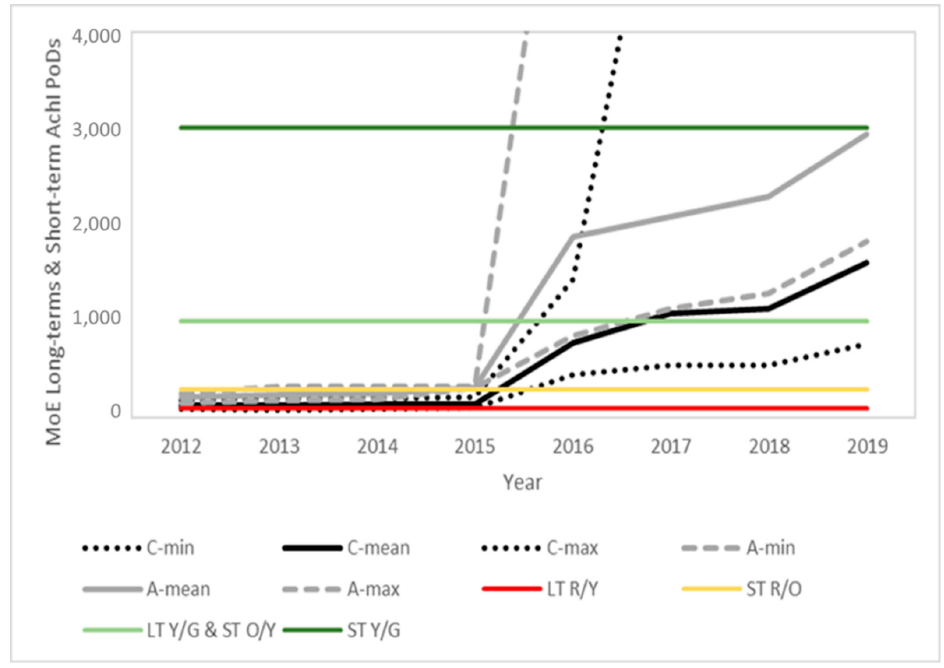
Figure 4. Time evolution of the margins of exposure for children (black) and adults (grey) for the long-term and short-term AChE PoDs predicted from the food monitoring data. Solid lines represent the mean value and dotted lines the maximum and minimum values for children (C) and adults (A), respectively. Color lines indicate the thresholds between the risk levels (see section 4 for details).